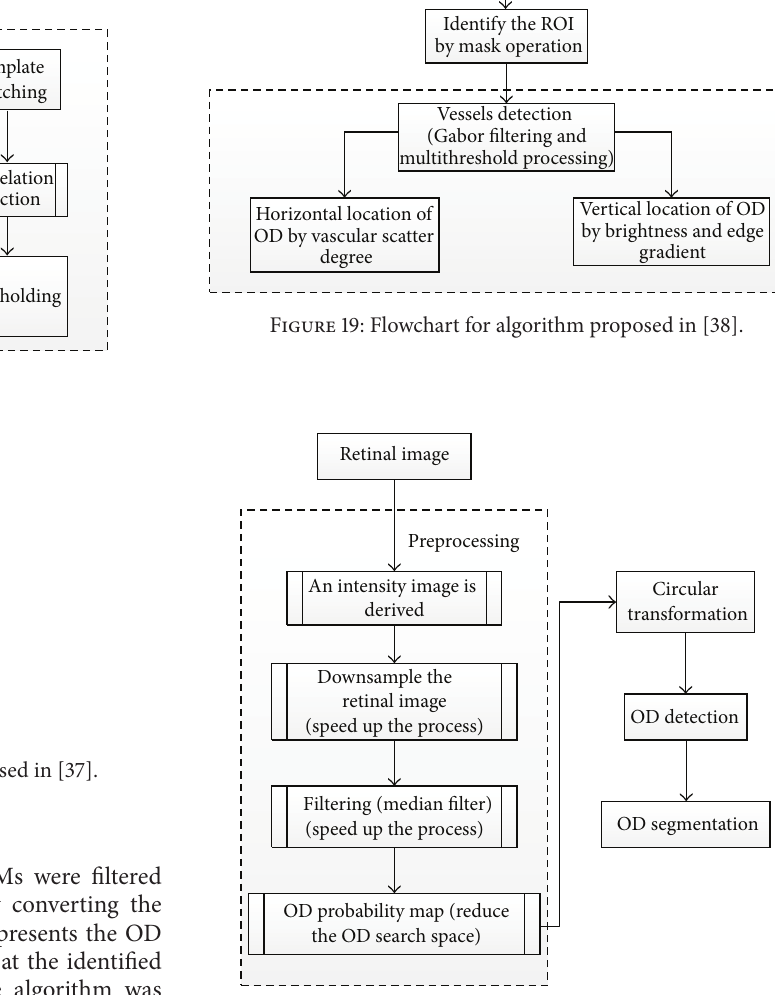
Figure 20: Flowchart for algorithm proposed in